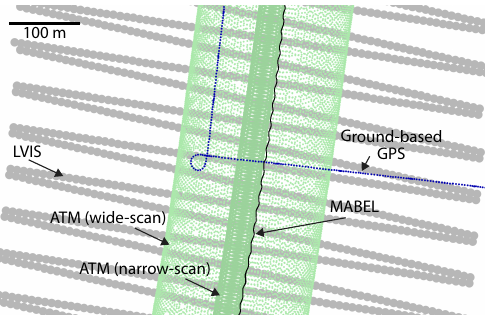
Figure 3. Schematic representation of the lidar measurement strate- gies and ground-based GPS sample spacing. LVIS measurements (gray): ∼ 10m diameter footprint and a 1000m across-track swath width. ATM measurements (green): ∼ 1m diameter footprint and either a 40m (narrow-scan; post 2012) or a 250m (wide-scan) across-track swath width. Ground-based GPS data (blue points) in- dicate sample spacing. MABEL measurements (black dots) are in- cluded to illustrate the limitations of a profiling lidar for this appli-